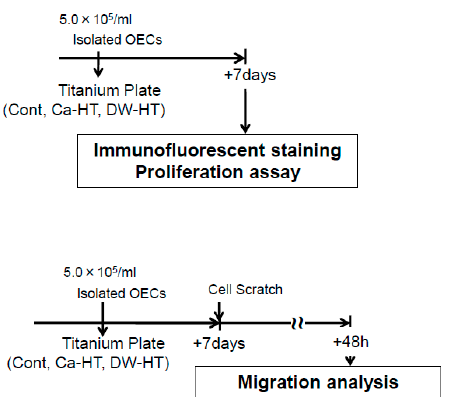
Figure 3. Experimental protocol for the in vitro study. Rat oral epithelial cells (OECs) were analyzed for changes in cell morphology 7 days after seeding OECs on Cont, hydrothermally-treated titanium in CaCl 2 solution (Ca-HT) or hydrothermally-treated titanium in distilled water (DW-HT) groups. For migration assay, confluent monolayers of OECs were scratched with a cell scraper and further cultured for 48 h. Afterward, cell number migrated into scratch area was counted.